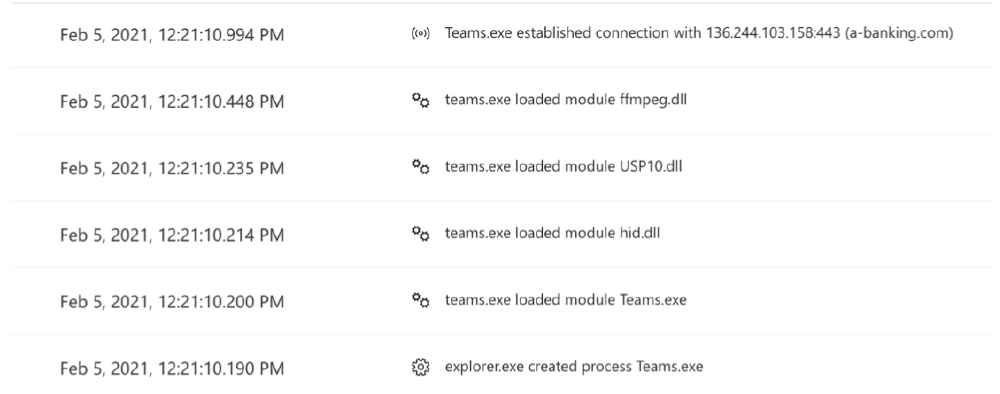
Figure 30. Timeline events for DLL sideloading by ATP.